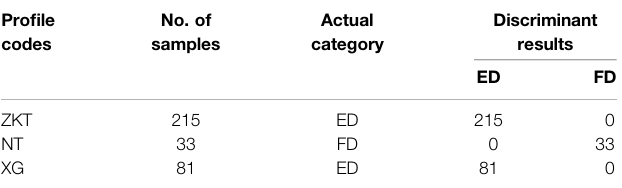
TABLE 6 | The veri fi cation of the discriminant